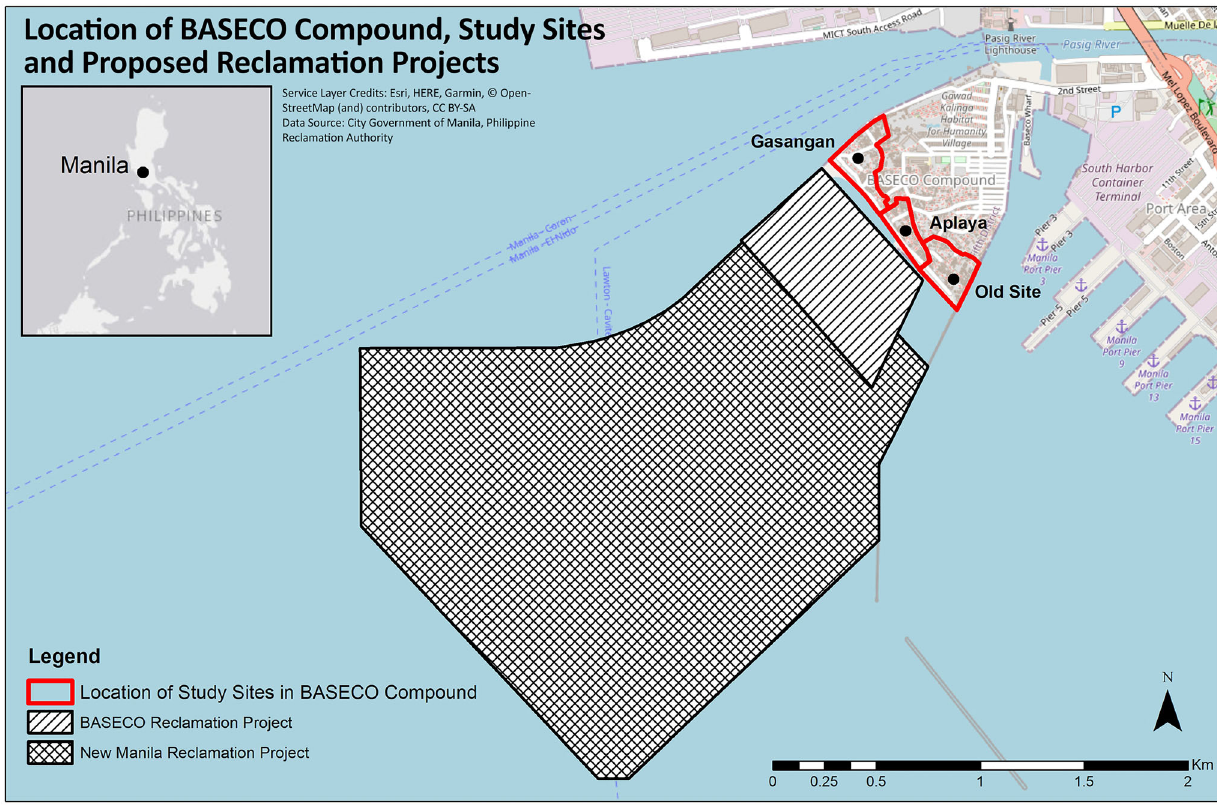
Fig. 1 Location of the Bataan Shipping and Engineering Company (BASECO) Compound in Manila, the study sites, and the proposed reclamation